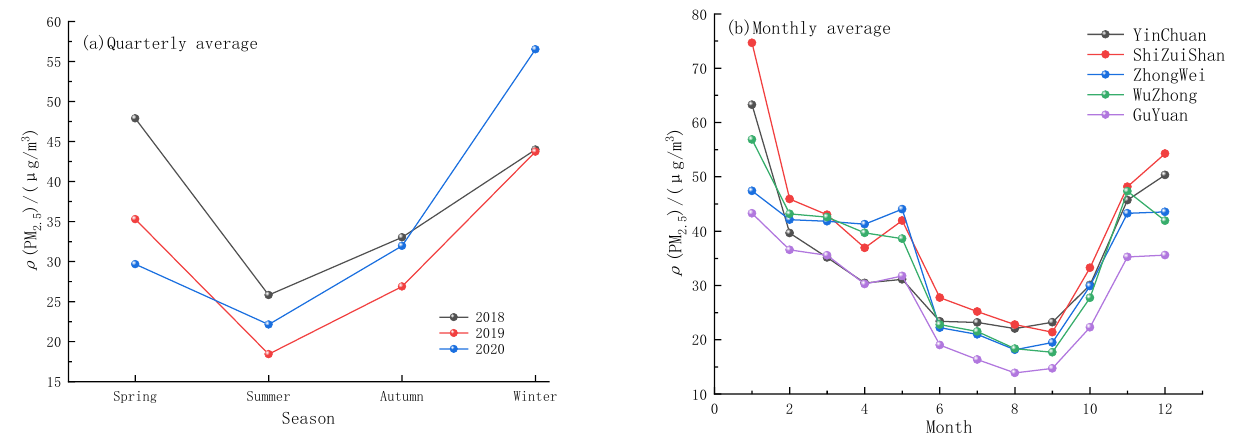
Figure 3. Statistics of seasonal and monthly mean value of PM 2.5 concentration. ( a ) Seasonal mean statistics of PM 2.5 concentration from 2018 to 2020; ( b ) Monthly mean statistics of PM 2.5 concentration in 5 cities